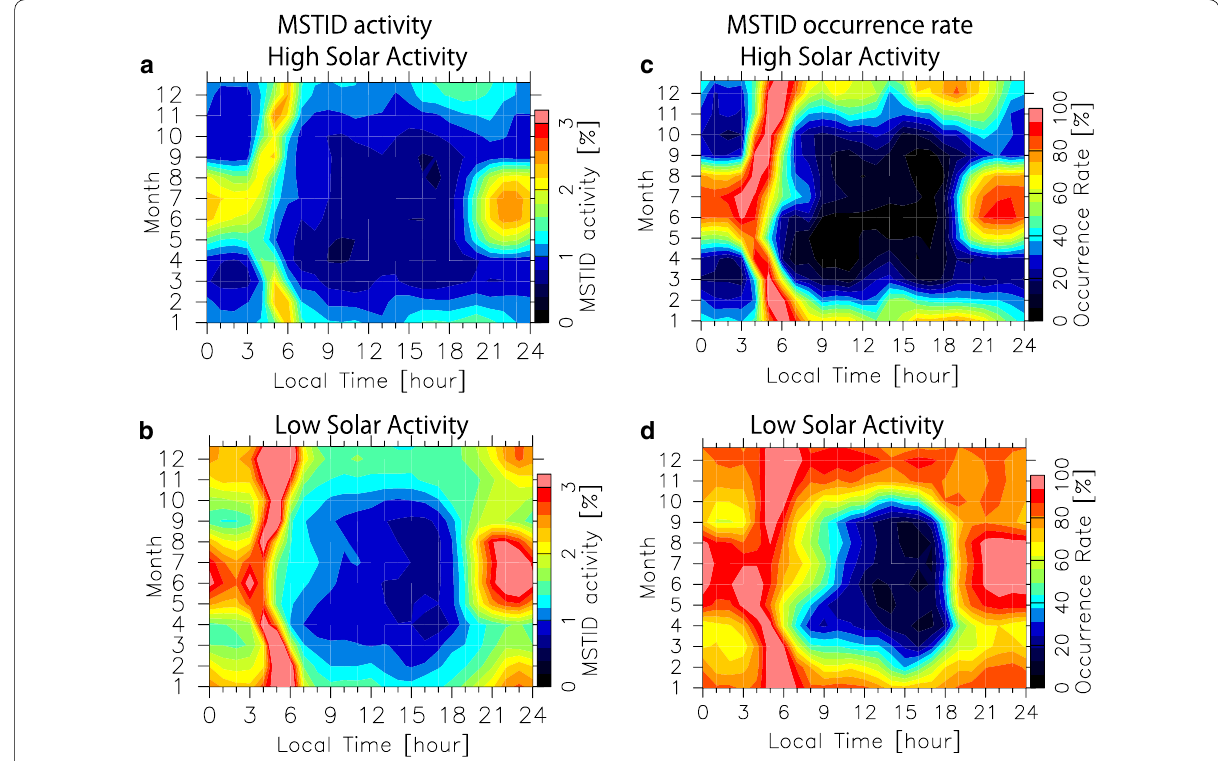
Fig. 4 Local time and seasonal variations of a , b MSTID activity and c , d MSTID occurrence rate averaged within an area of 133.0°–137.0° E and 33.0°–37.0° N under high and low solar activity